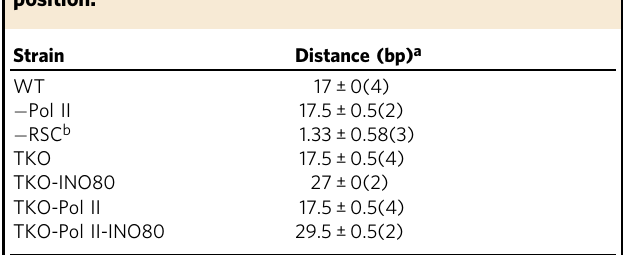
Table 1 Distances between MNase-Seq derived and calculated nucleosome af fi nities in the + 1 nucleosome